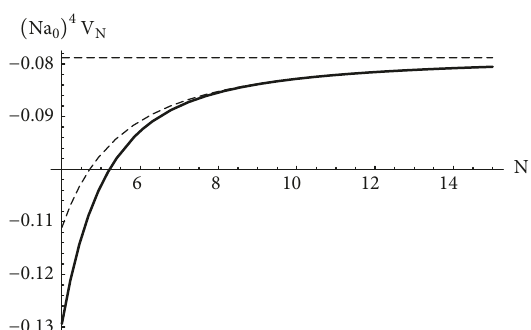
Figure 9: The graph Cartesian product 𝐶 9 × 𝑃 2 , or the prism graph 𝑌 9 .